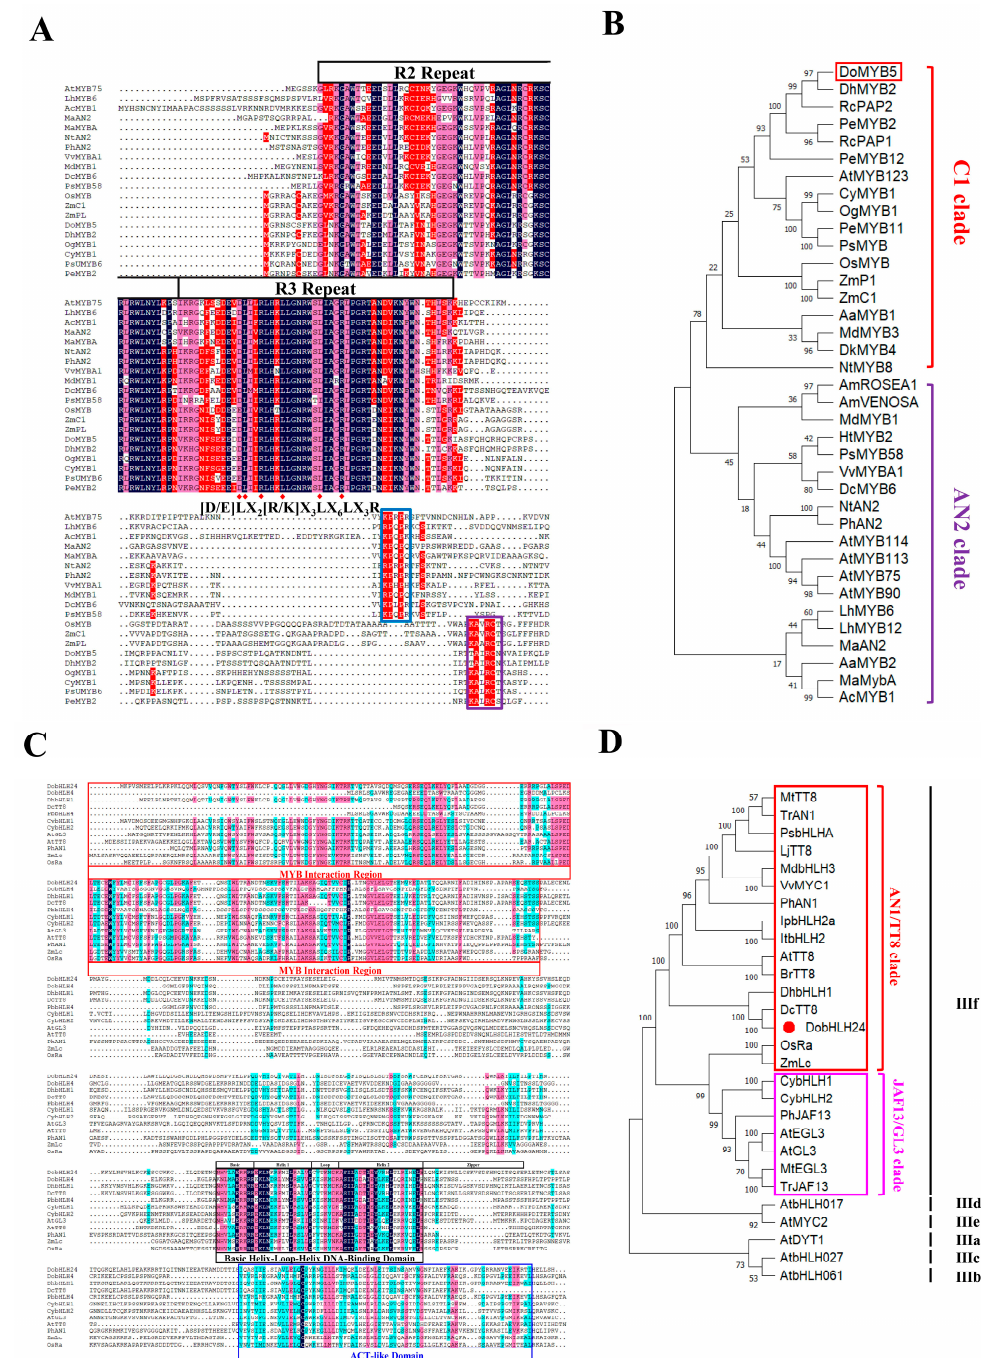
Figure 2. Sequence alignment and phylogenetic analysis of DoMYB5 and DobHLH24. ( A , C ) Align- ment of the protein sequence of MYBs ( A ) and bHLHs ( C ) from different species. ( B , D ) Phylogenetic analysis of DoMYB5 ( B ) and DobHLH24 ( D ) with selected transcription factors from other plant species.